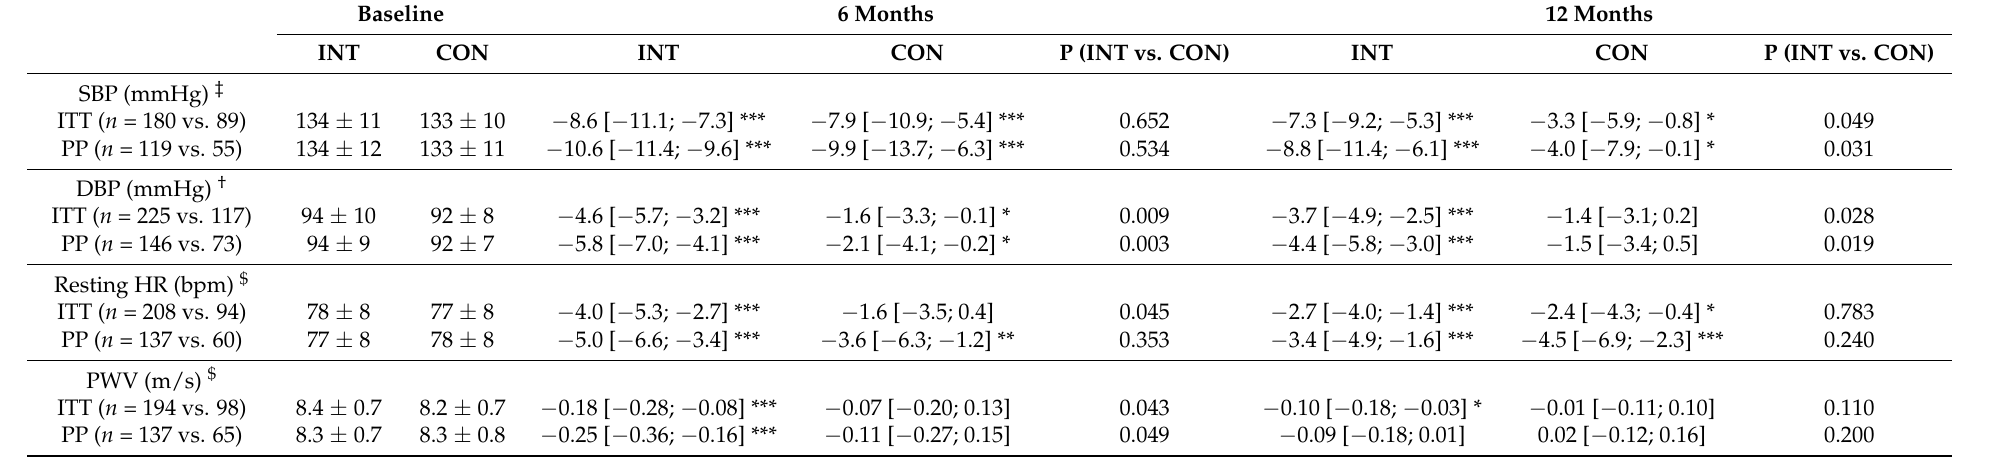
Table 2. Intra and intergroup changes in the INT and CON-group after 6 and 12 months compared to baseline focusing on individual risk groups.